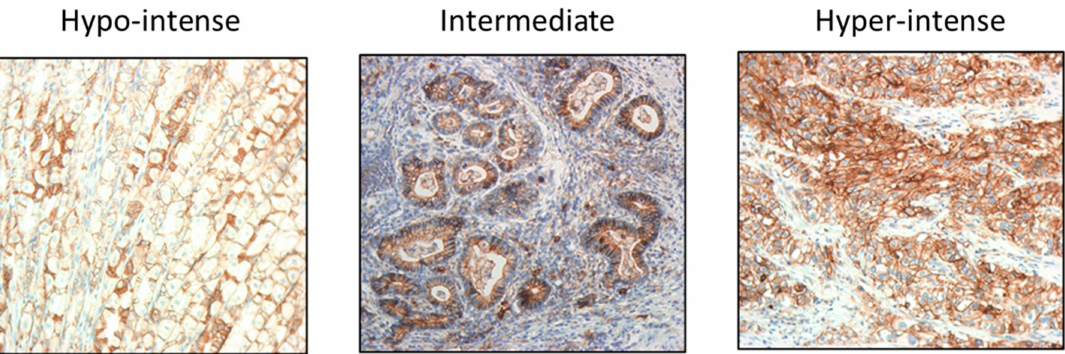
Figure 4. JAM-A expressional scoring in gastric full-face sections using a novel scoring algorithm. JAM-A immunohisto- chemistry (IHC) was performed on 4 µ m sections across 25 primary GE cancer cases. Membranous JAM-A expression was scored 0, 1+, 2+, 3+ based on completeness and intensity of staining; with each score given a % value for each section. Each percentage scored 1+ was then multiplied by 0.25, each percentage scored 2+ was multiplied by 0.5 and each percentage scored 3+ was multiplied by 1. The scores were then totaled to give a cumulative JAM-A intensity score. Cumulative scores < 33% were denoted as hypo-intense, 33–66% were deemed intermediate and scores > 66% were assessed as being hyper-intense for JAM-A expression. Images were obtained at 20 × magnification. Table 2. Weighted ranking system for immunohistochemical scoring of JAM-A on full-face GE cancer tissue sections. GE Full-Face Section Overall Score